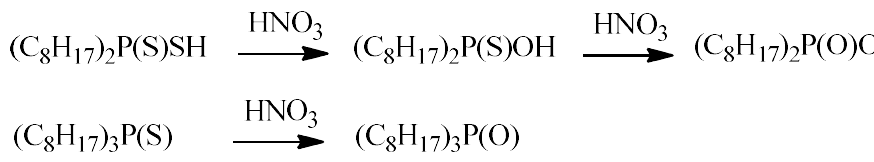
Figure 3. Oxidation of main components in Cyanex 301 and Cyanex 302 by 5 M HNO 3 results in Cyanex 272 and phosphine oxide, respectively. (Shaking time = 15 min and followed 10 days) [60]. Denote. C8H17 is a 2,4,4-trimethylpentyl